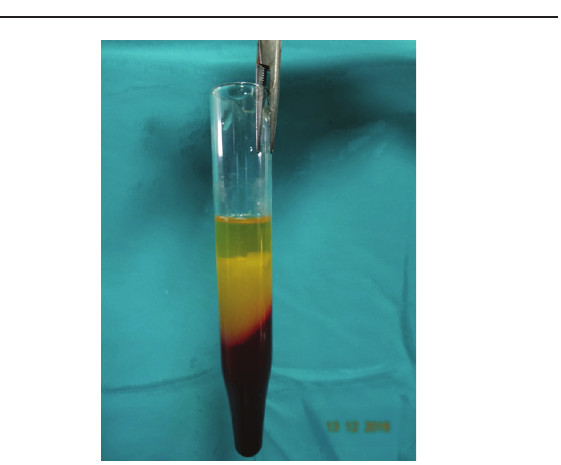
Blood was separated out into three layers in the test tube.